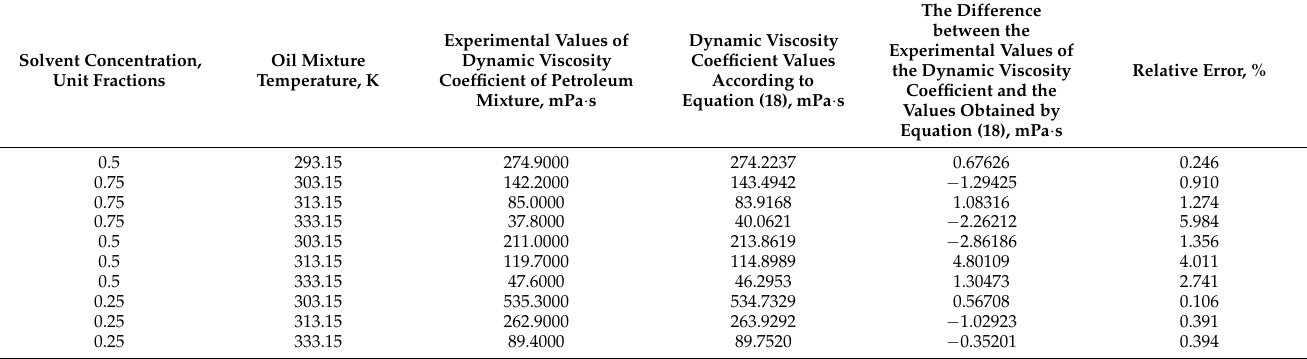
Table 11. Comparison of experimental data on the dynamic viscosity coefficient of the oil mixture with the results obtained from Equation (18).